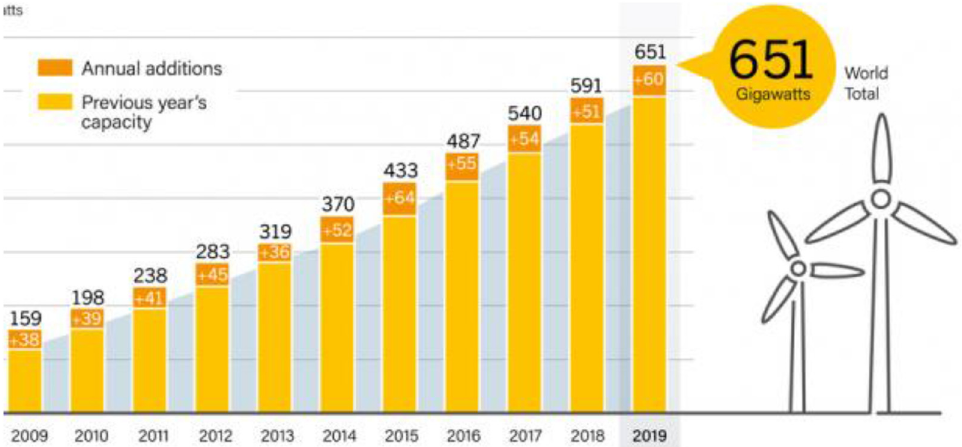
Fig. 24. Global wind energy capacity 2009 – 2019, in GW [31].